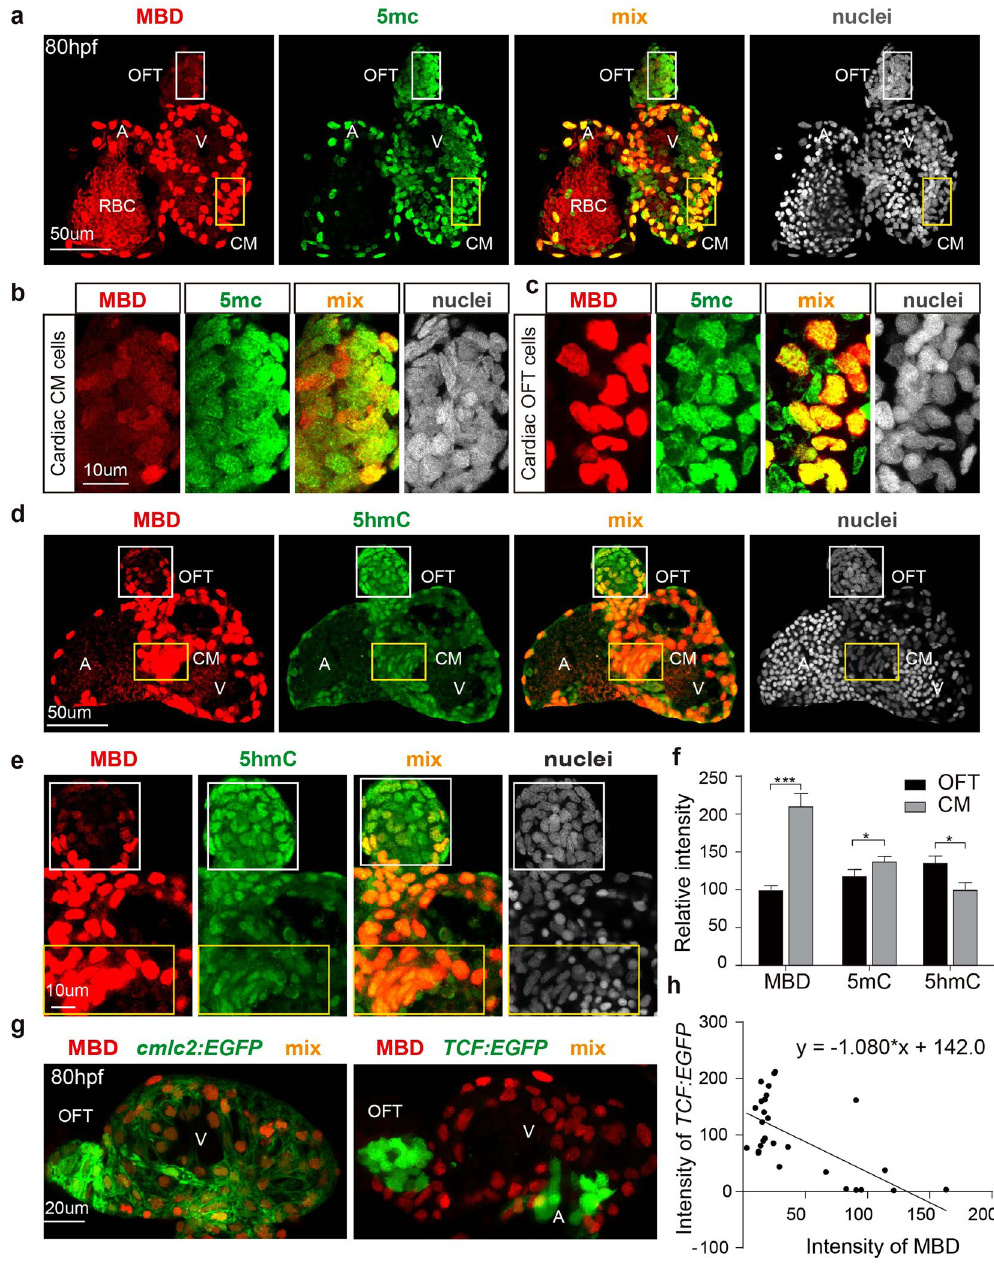
Figure 5. DNA methylation and hydroxymethylation patterns in the developing heart. ( a ) The distribution patterns for mCherry-MBD and 5 mC in the 80 hpf heart. ( b , c ) Magnified images of cardiac outflow tract cells (white boxes) and cardiac muscle cells (orange boxes) in A. A, atrium; V, ventricle; OFT, out flow tract; CM, cardiac muscle. ( d ) Comparison of mCherry-MBD and 5 hmC in the 80 hpf heart. ( e ) Magnified images of cardiac outflow tract cells (white boxes) and cardiac muscle cells (orange boxes) in D. ( f ) Fluorescence intensities of each group in the OFT and CM (p = 0.0105; N = 3) ( g ) The positional relationship of Wnt- responsive cells and mCherry-MBD expressing cells in 80 hpf heart. Left, cardiac muscle cells marked by cmlc2:EGFP ; right, Wnt-responsive cells marked by TCF:EG FP. ( h ) Linear regression of TCF and MBD signaling intensity (P value < 0.0001, N =